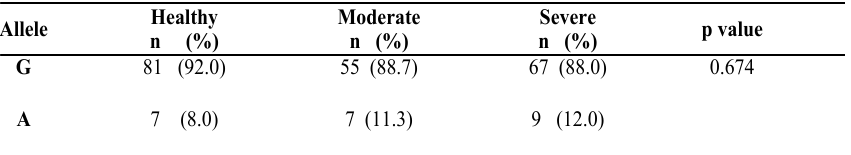
Table 3. Distribution of the TNF- α alleles in healthy, moderate and severe groups with chronic